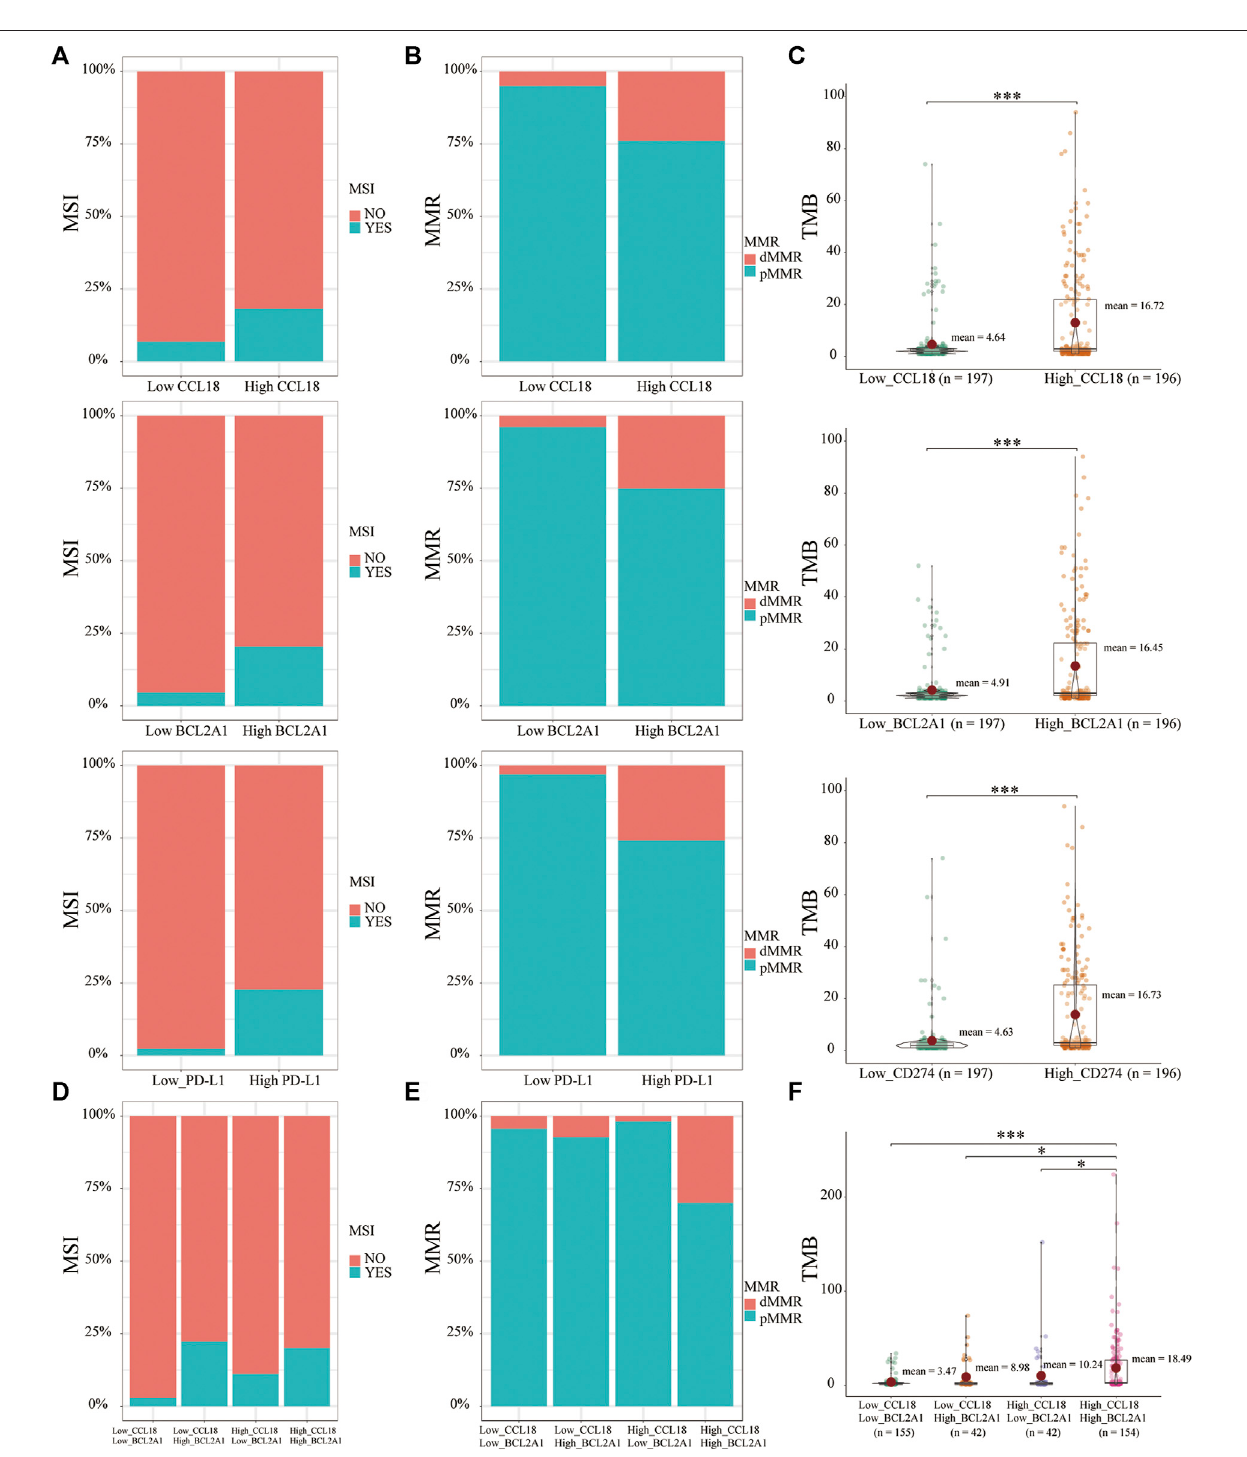
FIGURE7| TherelationshipbetweenMSI,dMMR,TMB,andCCL18,BCL2A1.SimilartoPD-L1,thehighCCL18orBCL2A1grouphadagreaterproportionof (A) MSI, (B) dMMR, and (C) more TMB. (D) Low_CCL18_High_BCL2A1 and High_CCL18_High_BCL2A1 groups had a greater proportion of MSI. Compared with the other three groups, the High_CCL18_High_BCL2A1 group had the highest proportion of (E) dMMR and the most (F) TMB. * p < .05, *** p < .001.